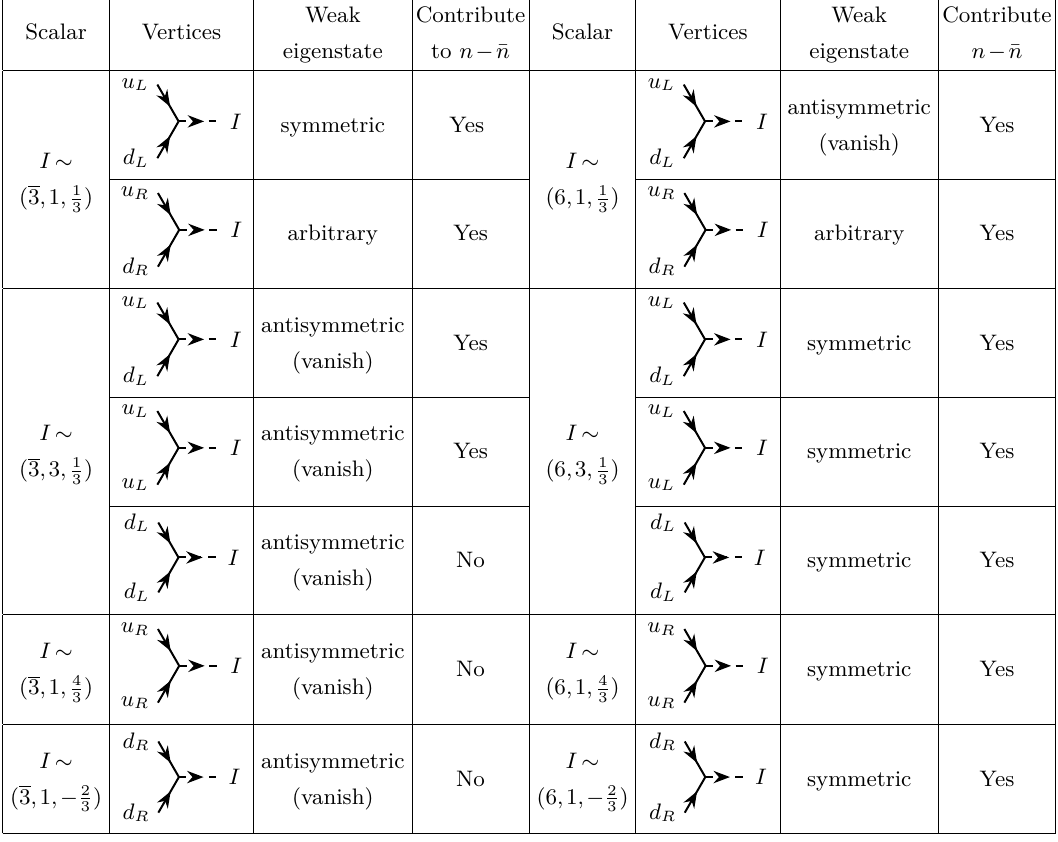
Table 2 . The quantum numbers of the possible scalars under the symmetry SU(3) C × SU(2) L × U(1) Y and the corresponding vertices which can contribute to neutron-antineutron